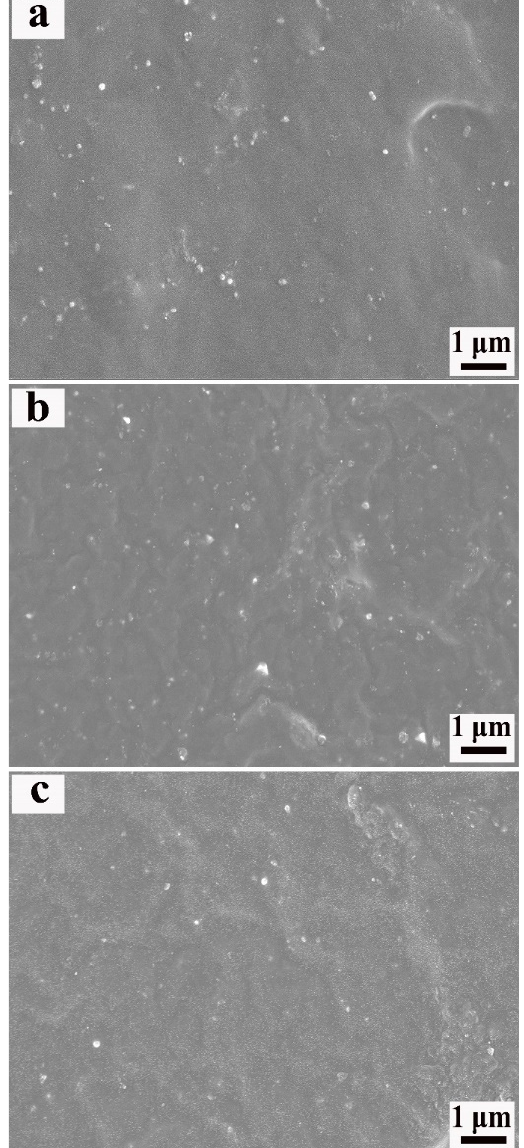
Figure 7. SEM images of the Si747@BTO/ENR composite with various loadings of ESO. ( a ) 10 phr, ( b ) 30 phr, and ( c ) 50 phr.